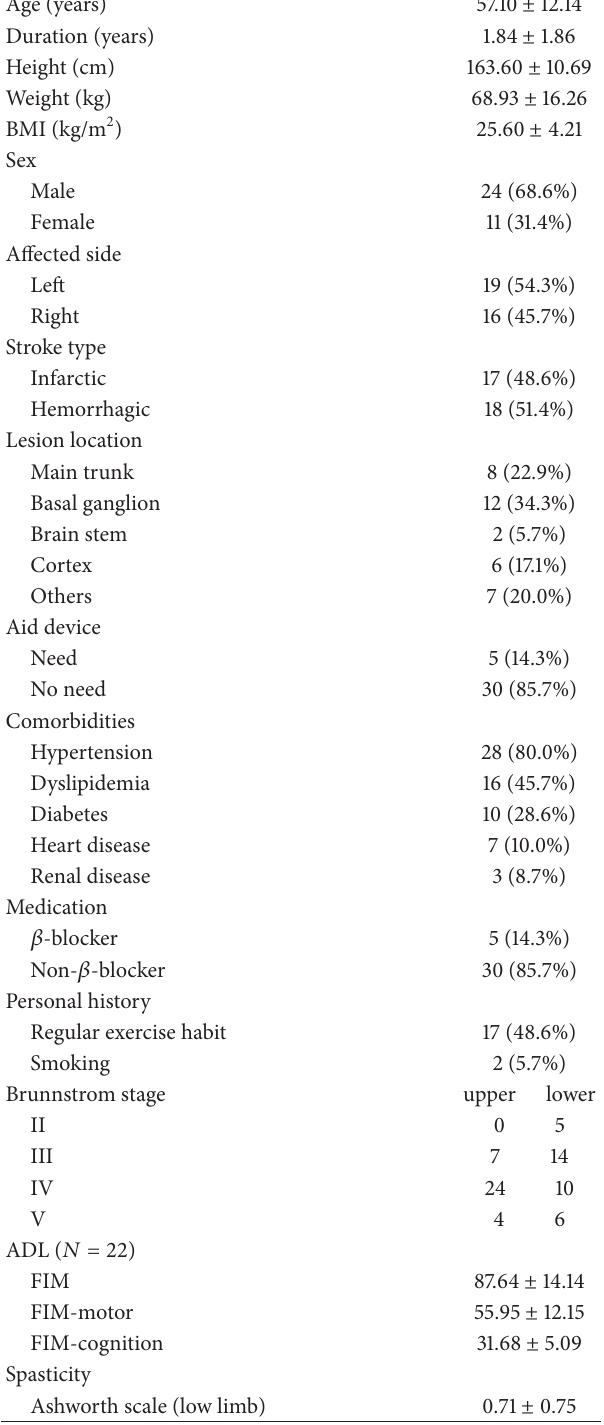
Table 1: Characteristics of participants ( 𝑁 = 35